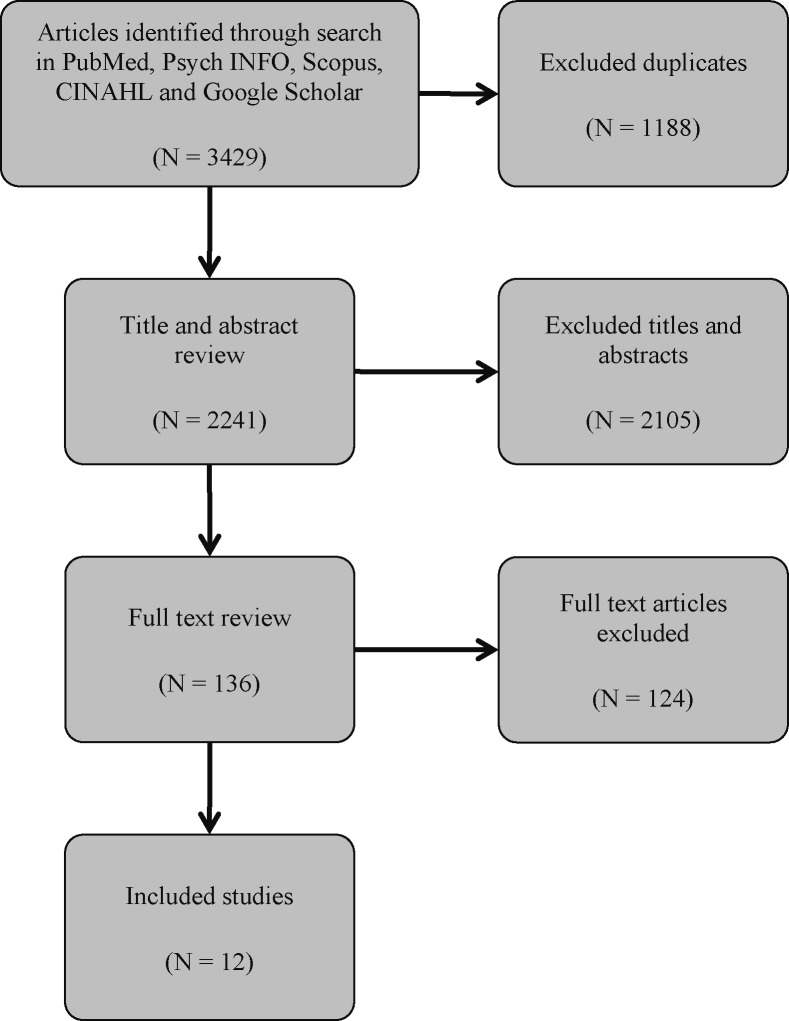
PRISMA flow-chart.